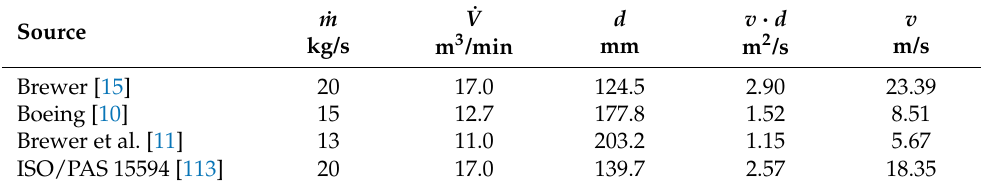
Table 1. Comparison of literature aircraft refueling flow rates for